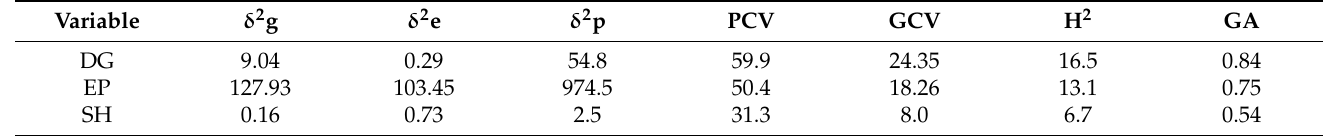
Table 7. Genetic parameters for agronomic traits of Lagenaria siceraria